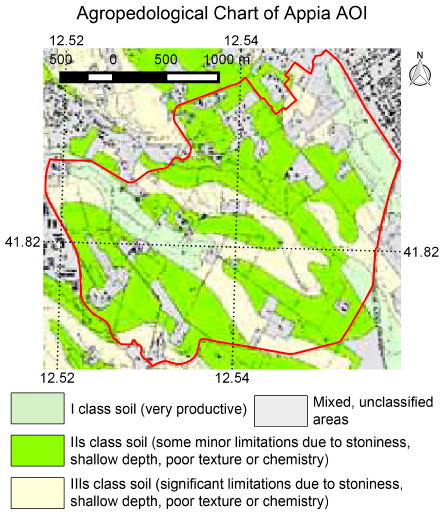
Figure 23. Land use map of Appia AOI (shown in red polygon), last updated in 2007, courtesy of the Comune di Roma [64].